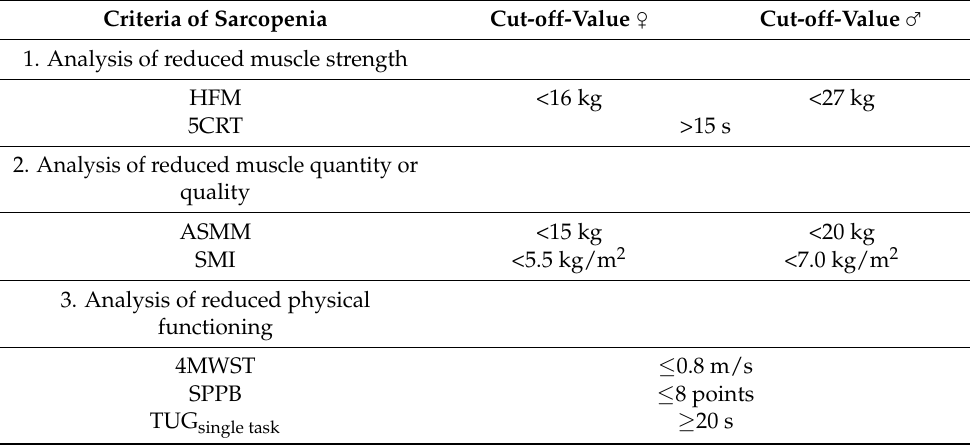
Table 2. Cut-off values of individual assessments according to EWGSOP2 (modified after [7]). Criteria of Sarcopenia